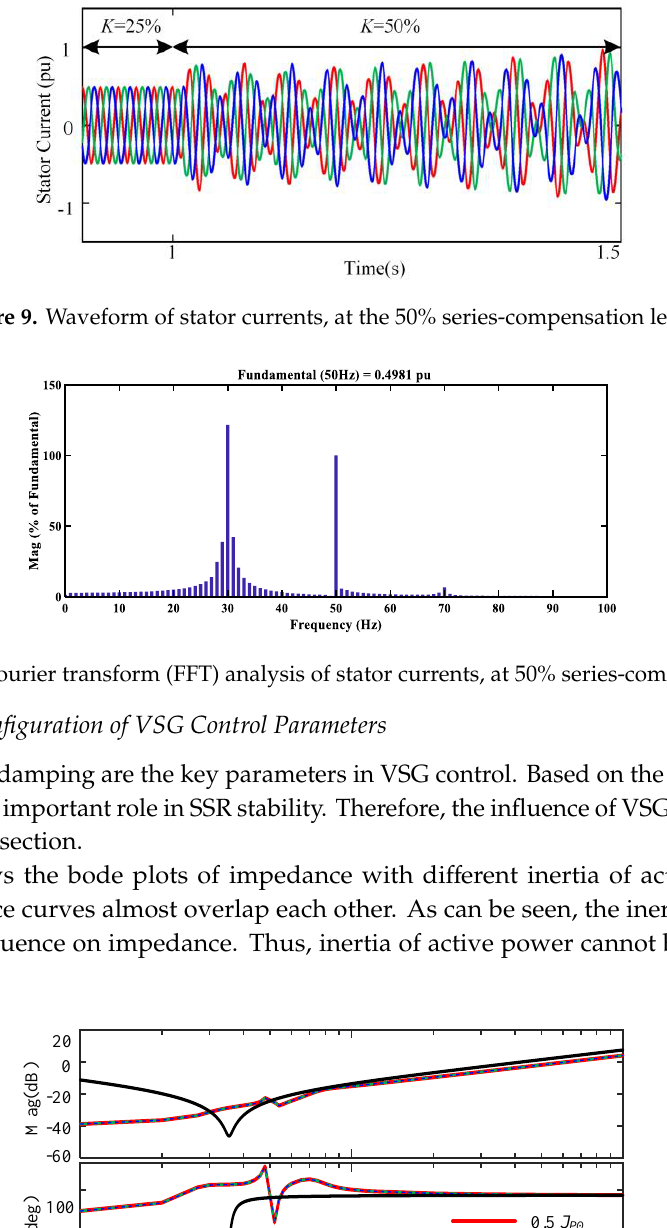
35 120 Figure 12. Bode diagram of different damping of active power. Red line: 0.5 D P 0 ; green line: D P 0 ; blue line: 1.5 D P 0. Figure 13 shows the bode plots of impedance with different inertia of reactive power control. As can be seen, with the inertia changing, the phase varies without obvious regularity. Therefore, the inertia of reactive power is not suitable for mitigating SSR. P h a s e ( d e g ) M a g ( d B ) 0 -100 100 0 -2020 -40 -60 10 100 35 110 Figure 13. Bode diagram of different inertia of reactive power. Red line: 0.5 J Q 0 ; green line: J Q 0 ; blue line: 1.5 J Q 0 . Figure 14 shows the bode plots of impedance with different damping of reactive power D Q . As can be seen, as D Q increases, the phase decreases significantly. It indicates that the damping of